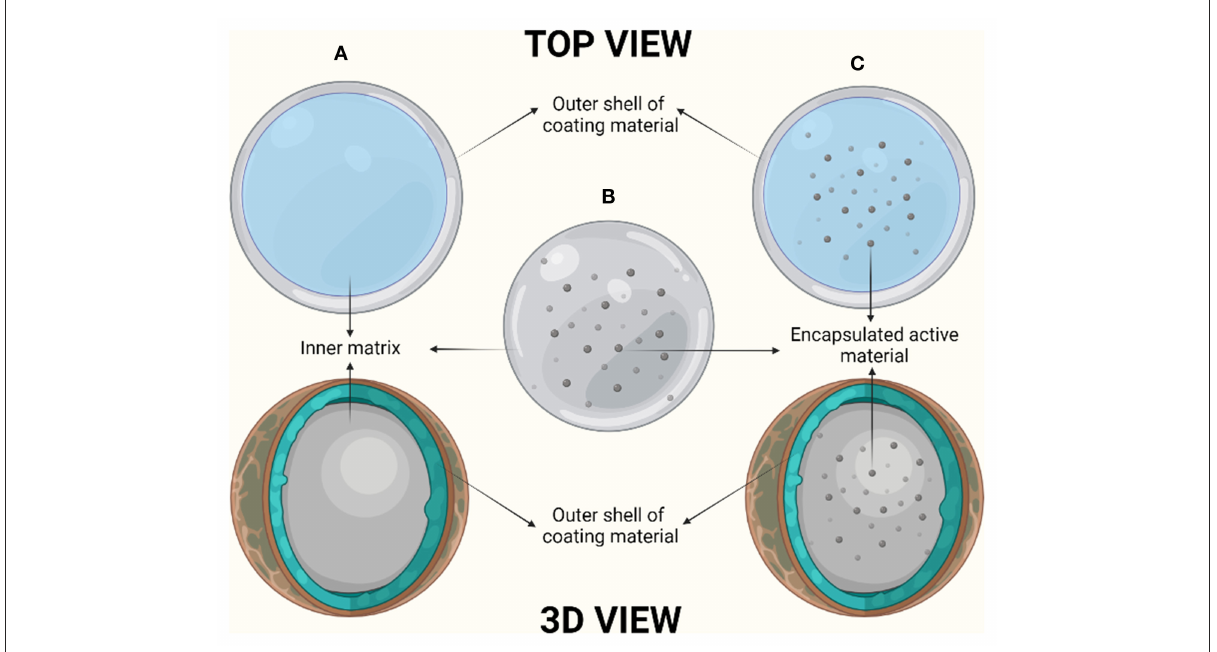
FIGURE1 Diagrammatic representation of encapsulation systems: (A) Reservoir, (B) Matrix, and (C) Coated